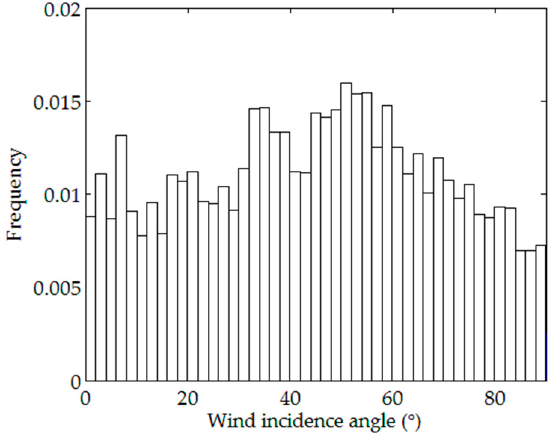
Figure 3. Wind incidence angle frequency distribution histogram in 2015.